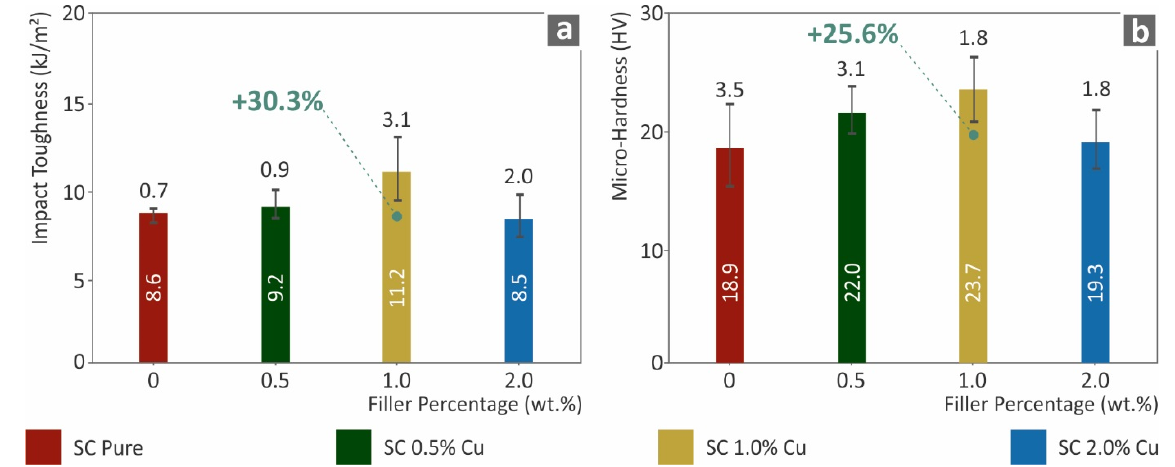
Figure 6. ( a ) Charpy’s notched impact toughness (kJ/m 2 ) to filler loadings (wt.%), ( b ) Vickers microhardness (HV) to filler ratios (wt.%).